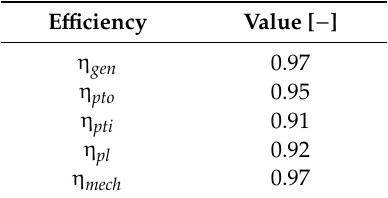
Table 2. E ffi ciency Table 2. Efficiency factors.